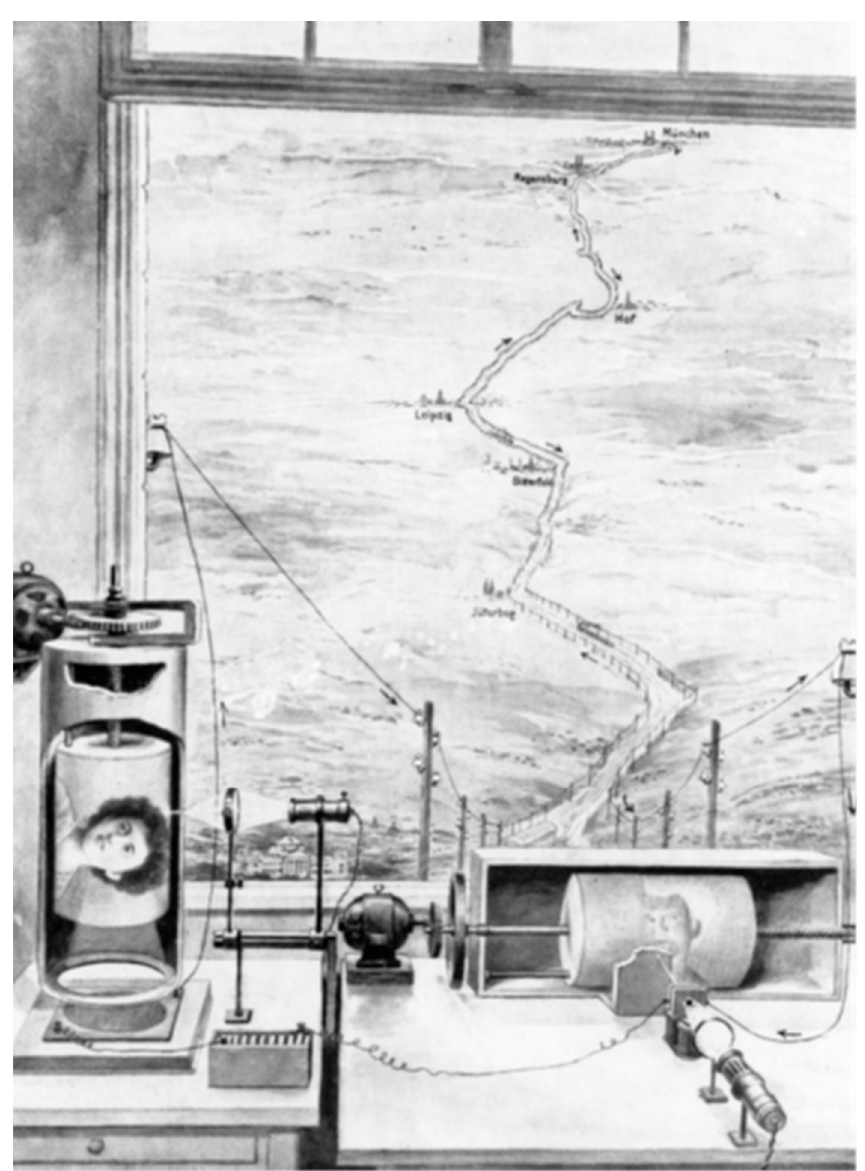
Figure2. IllustrationoftheBildtelegraph. © Figure 2. Illustration of the Bildtelegraph. © Stiftung Deutsches Technikmuseum Berlin, Historisches Archiv.